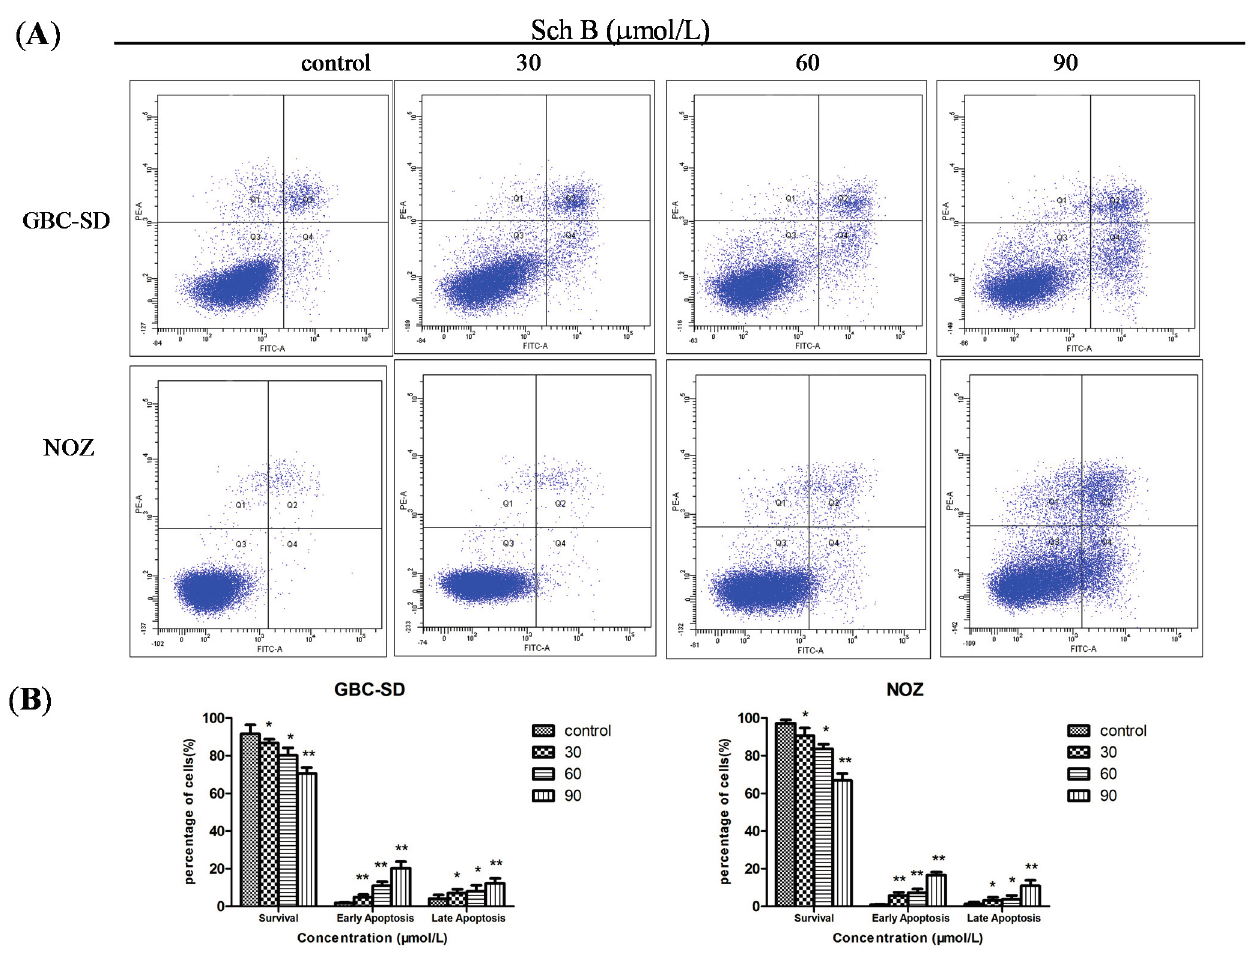
Figure 3. Sch B induces apoptosis in gallbladder cancer cells. ( A ) GBC-SD and NOZ cells were treated with Sch B (0, 30, 60, and 90 μ mol/L) for 48 h. Sch B-treated GBC-SD and NOZ cells were stained with annexin V-FITC/PI and analyzed by flow cytometry. ( B ) The percentage of apoptotic cells is presented as the mean ± SD (n = 3); Results shown were representative data from 3 independent experiments. * P < 0.05, ** P < 0.01 vs. the control